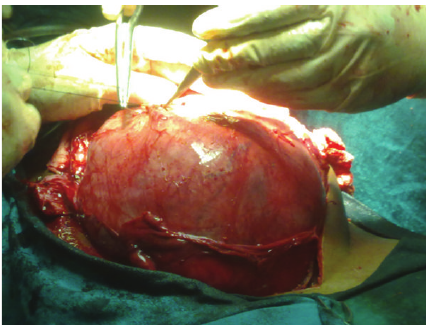
Figure 5: Immunohistochemistry of tumour showing S-100 positiv-